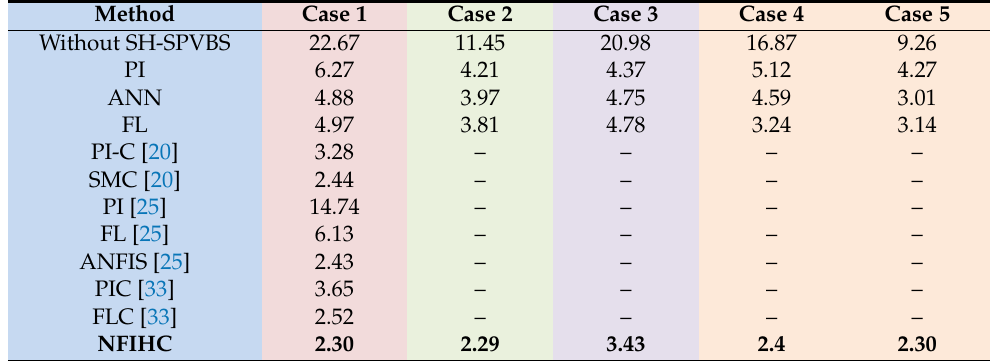
Table 6. % THD comparison of proposed controller with controllers that are available in the literature. Method Case 1